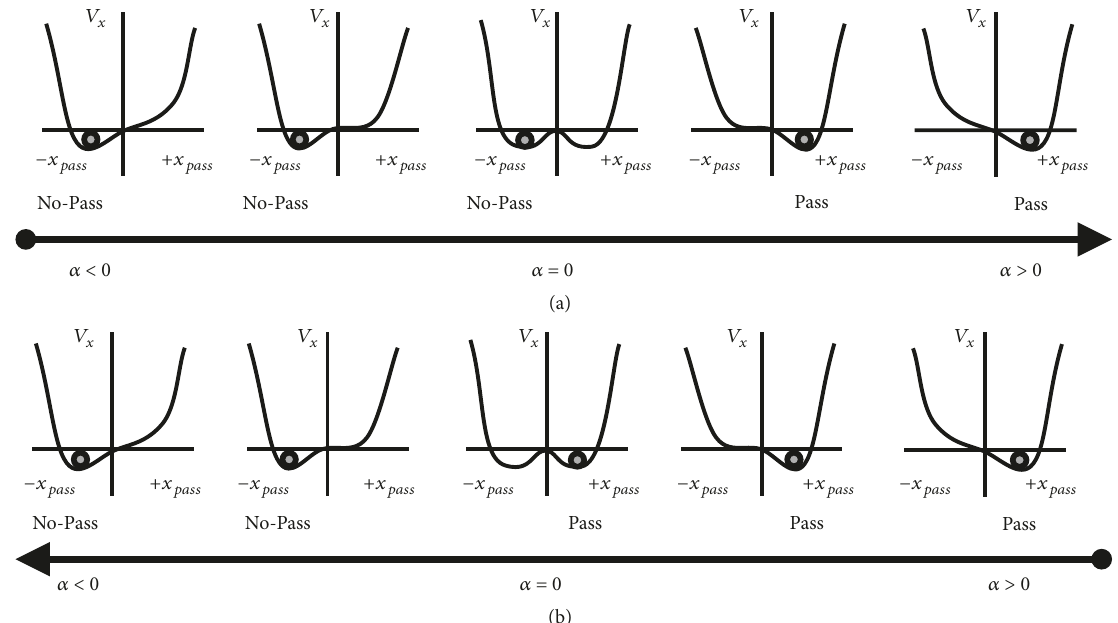
Figure 2: Illustrations of potential functions plotted for (3) and (4) for changes in the value of 𝛼 𝑠 . In (a), the value of 𝛼 𝑠 increases from 𝛼 𝑠 < 0 to > 0 . As 𝛼 𝑠 approaches 0, the system becomes bistable but continues to converge on a stable solution at −𝑥 𝑝𝑎𝑠𝑠 . As 𝛼 𝑠 increases and −𝑥 𝑝𝑎𝑠𝑠 becomes less stable the system eventually converges on the solution at +𝑥 𝑝𝑎𝑠𝑠 . In (b) the value of 𝛼 𝑠 decreases from 𝛼 𝑠 > 0 to 𝛼 𝑠 < 0 , exhibiting the same characteristics as illustrated in (a) but in the opposite direction (figure modified from